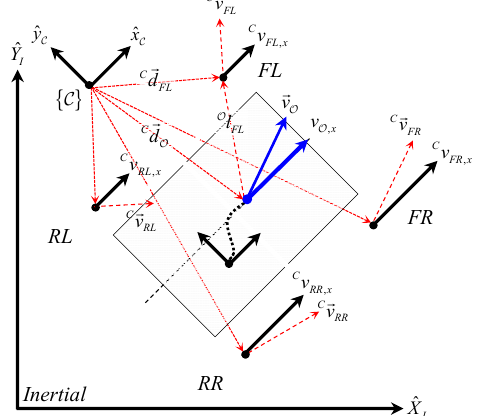
Figure 2. Coordinate frames of conventional planar SSMR kinematics defined on the inertial XY ‑ plane. The z axes of the frame {𝒞} and {𝒪} are all out of the page.